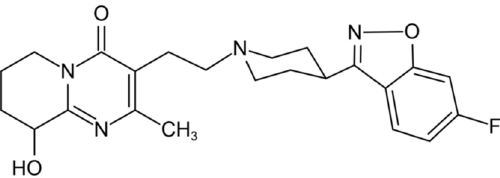
Figure 1. The chemical structure of paliperidone (PPD; M.W. 426.48, Log P 3.0, pKa 1 = 8.2, piperidine moiety; pKa 2 = 2.6, pyrimidine moiety [12]).